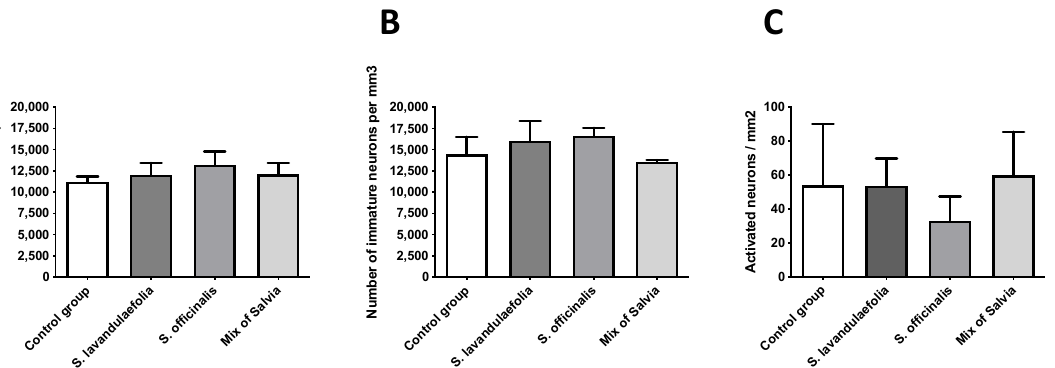
Figure 5. Chronic mix of Salvia supplementation did not impact neurogenesis and neuronal activity. ( A ) Number of total neurons by mm 3 evaluated with doublecortin (DCX) staining in dentate gyrus of hippocampus (n = 4 per group). ( B ) Number of immature neurons by mm 3 evaluated with doublecortin (DCX) staining in dentate gyrus of hippocampus (n = 4 per group). ( C ) Evaluation of neuronal activity with c-Fos staining (n = 4 per group). All analyses were done using a one-way